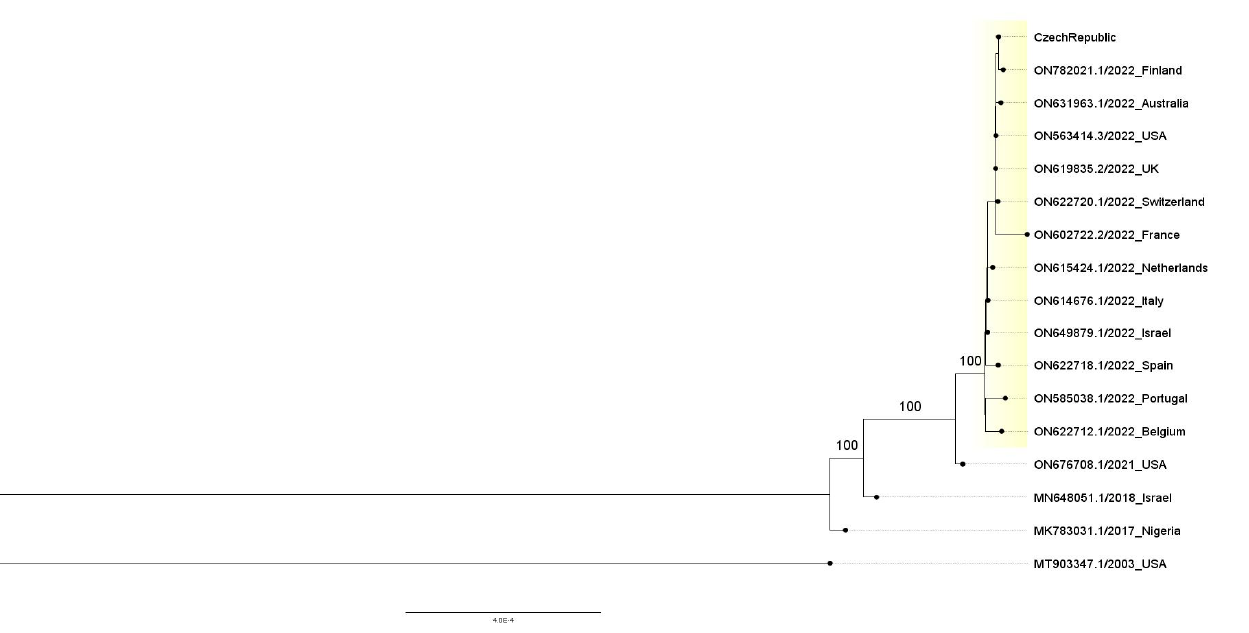
Figure 1. Orthopoxvirus particles. Transmission Electron Microscopy. magnification—150,000×. The length of the white bar in the right bottom corner represents 100 nm.